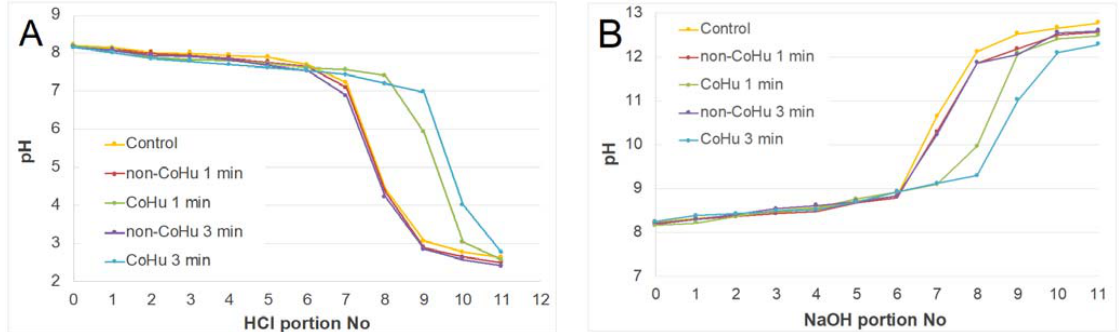
Figure 7. ( A ) A typical curve of titration of 0.01 M bicarbonate buffer treated with CoHu or non-CoHu with 0.1 M HCl and ( B ) with 0.1 M NaOH. Some samples were treated with the airstream for 3 min.